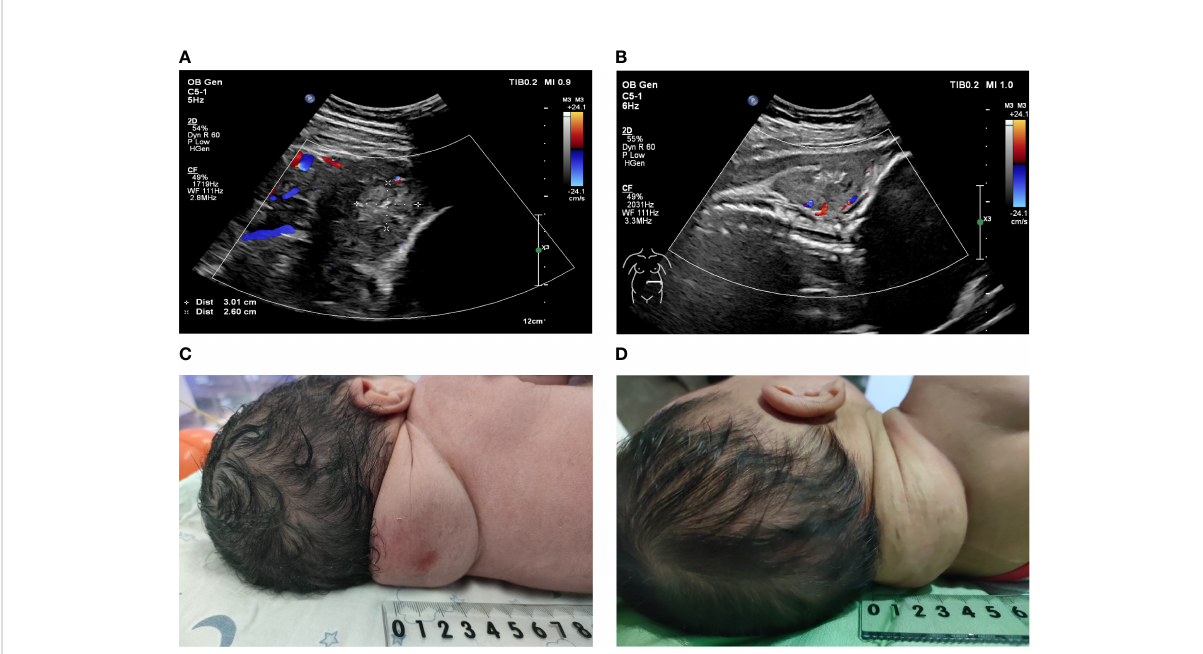
FIGURE 4 (A, B) : Doppler ultrasonography was used to observe the blood fl ow signal of the fetal posterior neck tumor after surgery. (A) One week after surgery; (B) One month after surgery. (C) : A solid and soft mass of approximately 6 × 5 × 4 cm protruded from the posterior neck of the newborn. (D) : A solid and soft mass of approximately 5 × 3 × 3 cm protruded from the posterior neck of the 42-day-old